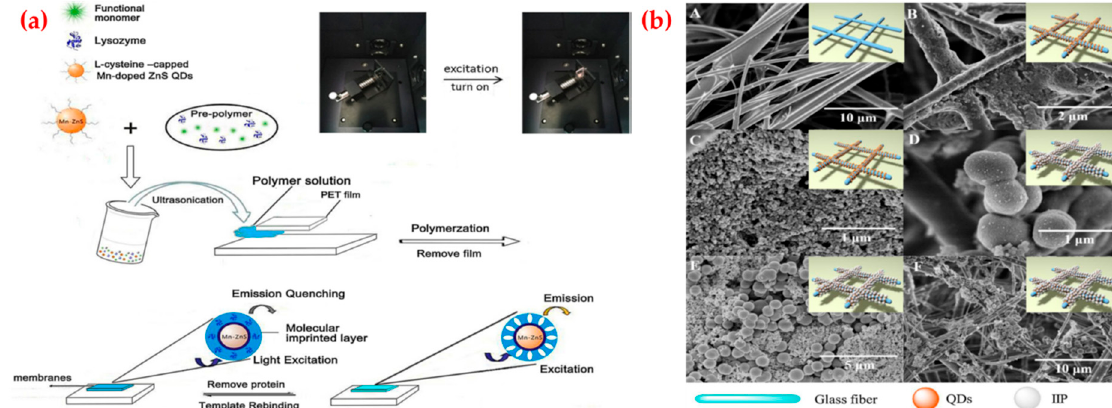
Figure 4. ( a ) Synthesis of quantum dots embedded imprinted membranes and ( b ) scanning electron microscope images of paper and quantum dots based ion-imprinted polymers: (A) the bare, (B) quantum dots grafted on the glass fiber, (C) quantum dots; (D) ion-imprinted polymer; (E) ion-imprinted polymer bonded with the quantum dots; (F) ion-imprinted polymer and quantum dots bound on the glass fiber. Republished with permission from [108,110]; permission conveyed through the Copyright Clearance Center, Inc.